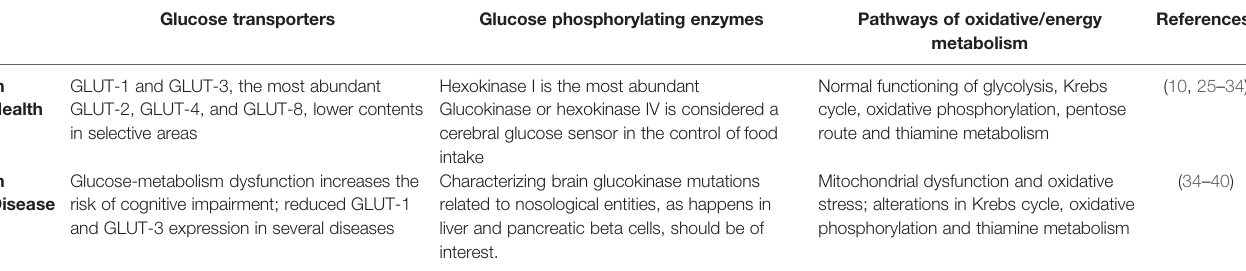
TABLE 1 | Some aspects of brain glucose metabolism in health and disease. Glucose